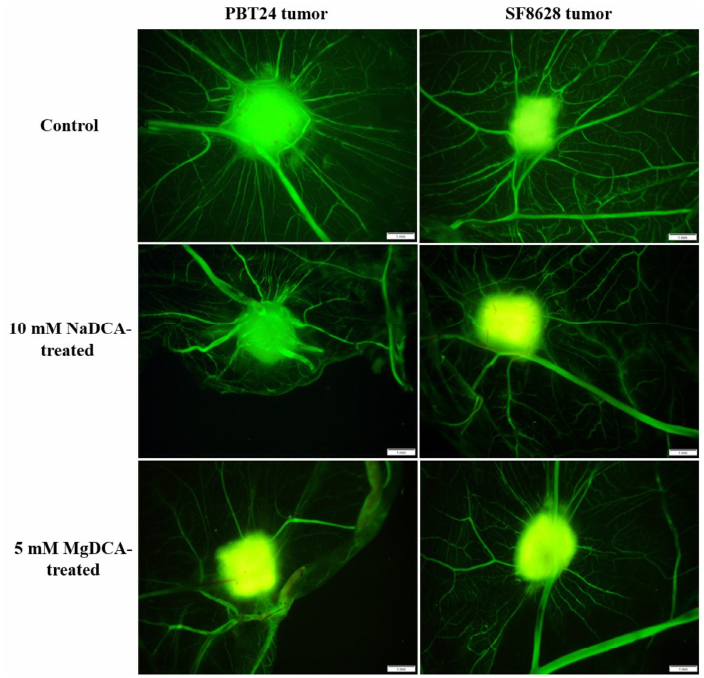
Figure 2. Fluorescent stereomicroscopic images of PBT24 and SF8628 tumors (fluorescent dextran highlights the tumor and surrounding blood vessels). Scale bar is 1 mm. highlights the tumor and surrounding blood vessels). Scale bar is 1